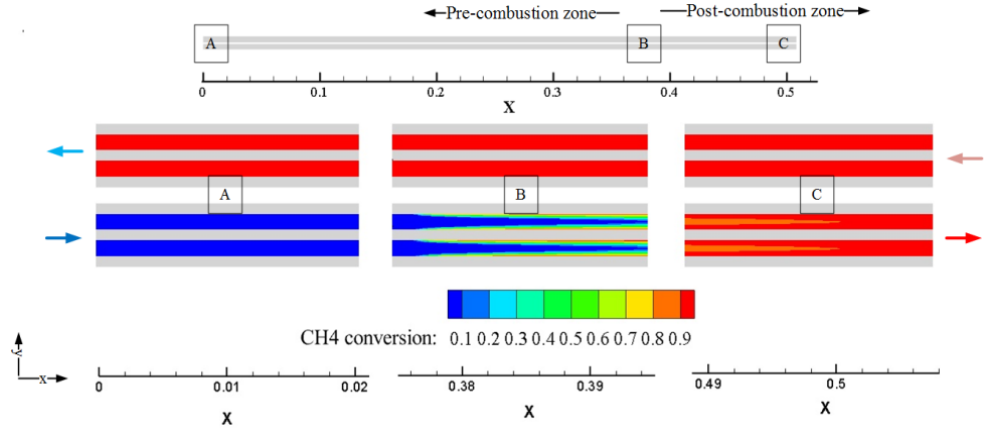
Figure 4. Contour of methane conversion. v = 20 m/s, t = 10 s, C ch4 , in = 2%.